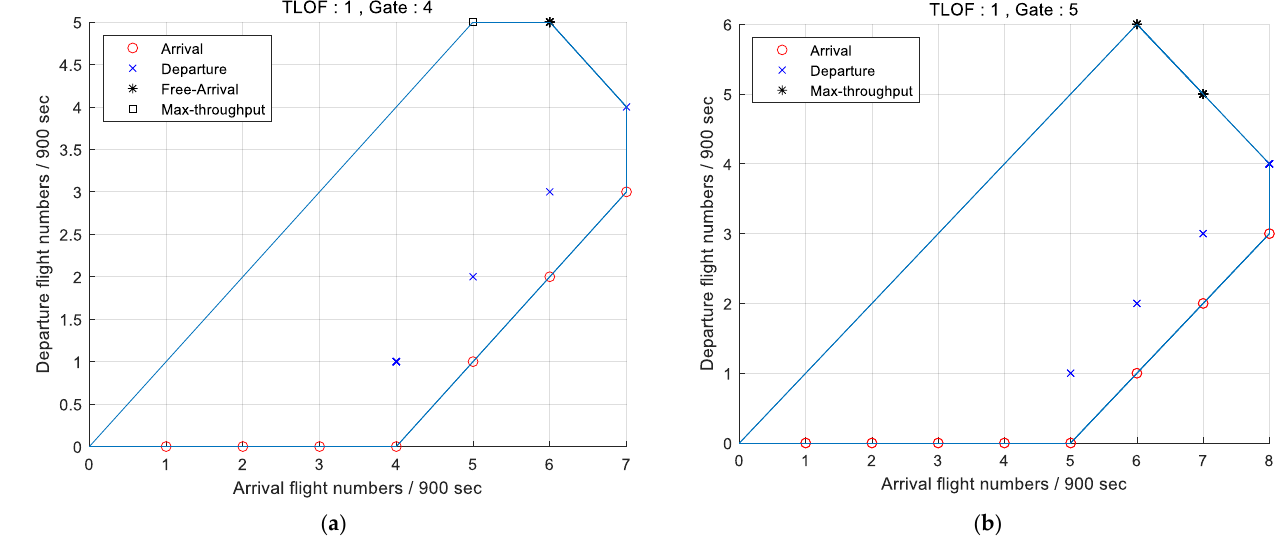
Figure 31. Capacity of a satellite topology for the current Gimpo Airport parking lot that complies with the EASA’s new regulations: ( a ) 1 TLOF, 4 Gates; ( b ) 1 TLOF, 5 Gates.